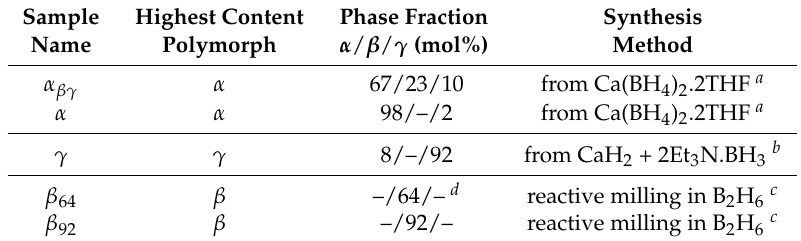
Table 1. Sample list. Phase fractions were obtained from PXD patterns using F2dd [17], Pbca [18] and P-4 [17] for α -, γ - and β -Ca(BH 4 ) 2 , respectively. Other phases, except for CaH 2 and FeNi 3 in β 92 , where not taken into